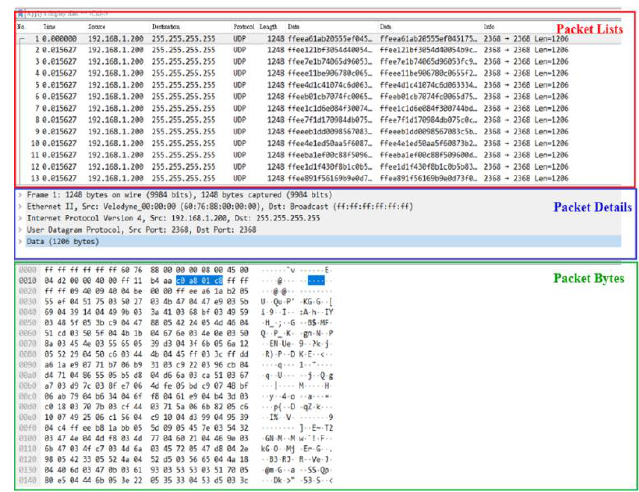
Figure 1. Package